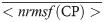
Time-development of the characteristic behaviors of SOC.A) MCF-7 cells and B) HL-60 cells. At each experimental time point, tj (A: 18 time points and B: 13 points; Methods), the (ensemble) average nrmsf value of the CP at t = tj, <nrmsf(CP(tj))> is evaluated at the sandpile-type critical point (top of the sandpile: right panels). In the top center panels, <nrmsf(CP(tj))>, is plotted against the natural log of tj (A: min and B: hr). Error bar represents the sensitivity of <nrmsf(CP(tj))> around the CP(tj), where the bar length corresponds to the change in nrmsf in the x-coordinate (fold-change in expression) from x(CP(tj))—d to x(CP(tj)) + d for a given d (A: d = 0.005; B: d = 0.01; due to much more mRNAs in MCF-7 cells). Temporal averages of <nrmsf(CP(tj))> are A) <nrmsf(CP)>¯HRG = 0.094 and <nrmsf(CP)>¯EGF = 0.081, and B) <nrmsf(CP)>¯DMSO, atRA = 0.078, where an overbar represents temporal average. Note: An overbar for a temporal average is used when ensemble and temporal averages are needed to distinguish. A) MCF-7 cells: The temporal trends of <nrmsf(CP(tj))> are different for HRG and EGF. The onset of scaling divergence (left panels: second and third rows) occurs at around <nrmsf(CP)>¯ (black dashed line), and reflect the onset of a ‘genome avalanche’ (Methods). B) HL-60 cells: The trends of <nrmsf(CP(tj))> for the responses to both DMSO (black line) and atRA (blue) seem to be similar after 18h (i.e., global perturbation; see section VI). The scaling-divergent behaviors for both DMSO and atRA reveal the collapse of autonomous bistable switch (ABS [10,11]) exhibited by the mass of groups in the scaling region (black solid cycles) for both DMSO and atRA. The onset of divergent behavior does not occur around the CP (<nrmsf(CP)>¯ = 0.078), but rather is extended from the CP (see section III). The power law of scaling behavior in the form of 1- <nrmsf> = α<ε>-β is: A) α = 1.29 & β = 0.172 (p< 10−10) for HRG, and α = 1.26 & β = 0.157 (p<10−9) for EGF; B) α = 1.60 & β = 0.301 (p< 10−6) for DMSO, and α = 1.42 & β = 0.232 (p< 10−6) for atRA. Each dot (different time points are shown by colors) represents an average value of A) n = 742 mRNAs for MCF-7 cells, and B) n = 505 mRNAs for HL-60 cells.